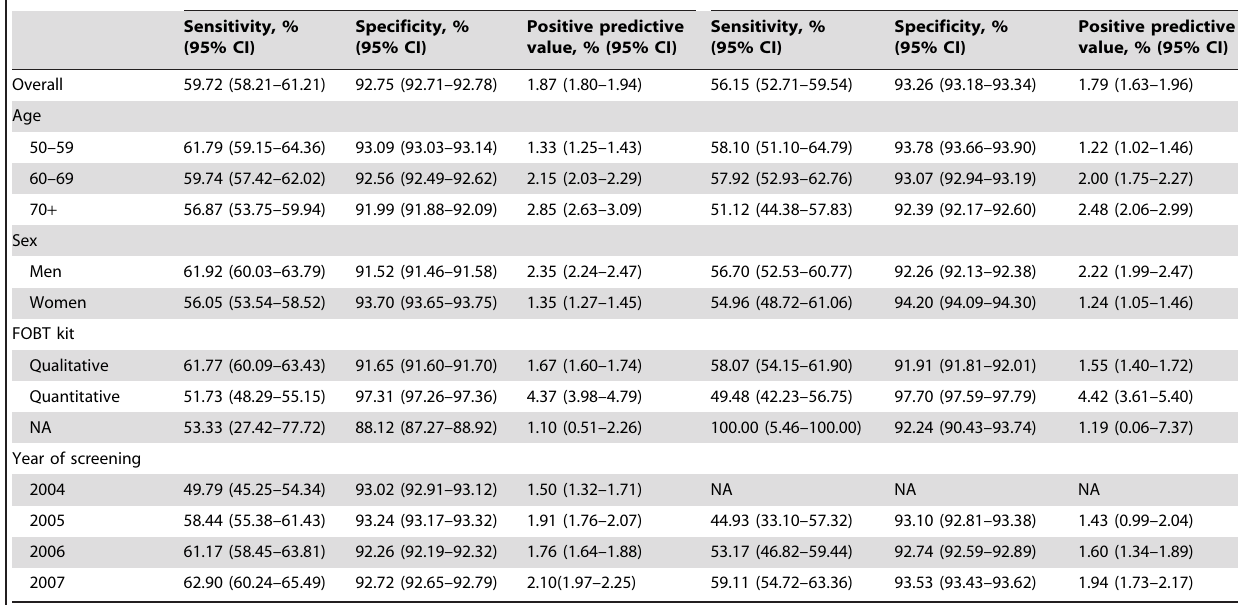
Table 3. Validity of FOBT for colorectal cancer.